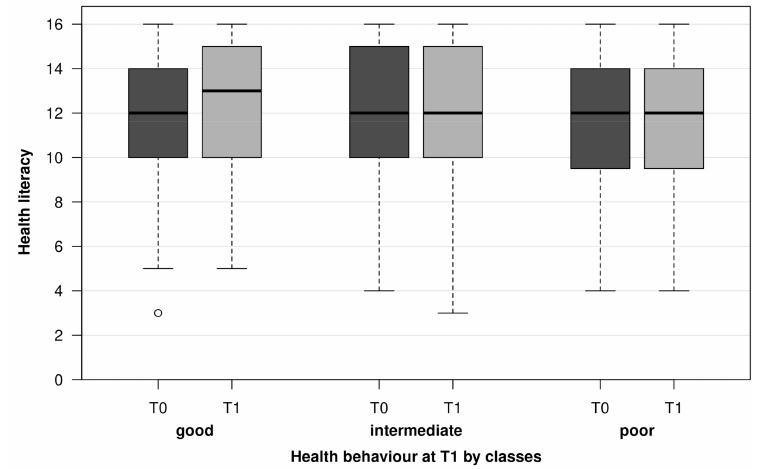
Figure 2. Distribution of HL at T0 and T1 over health behaviour into 3 classes at